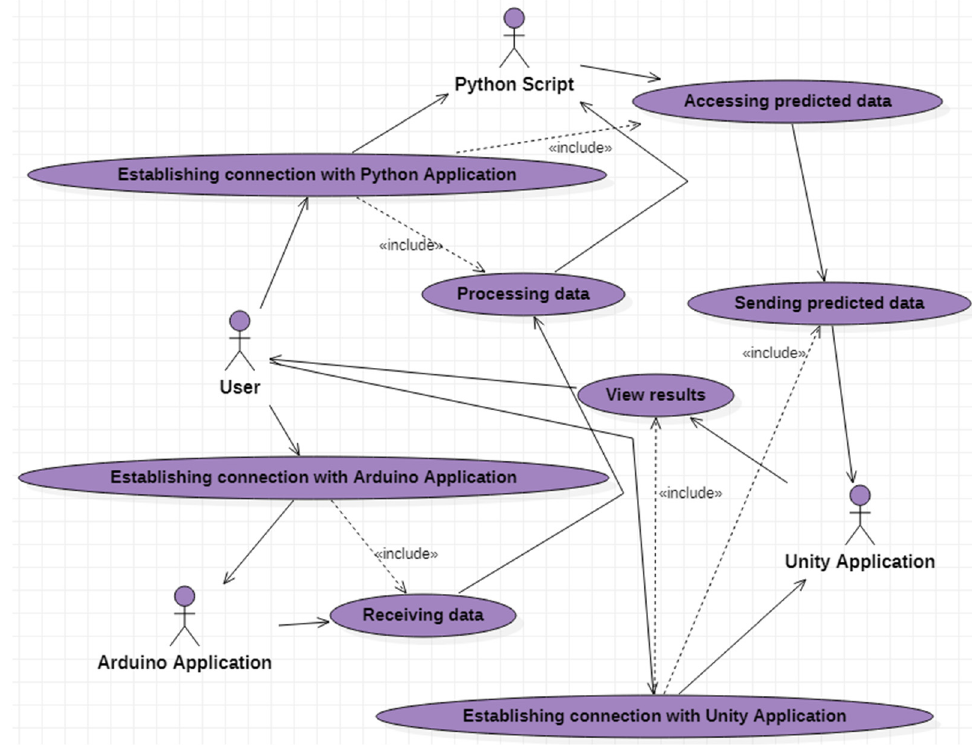
Figure 9. UML use cases diagram.